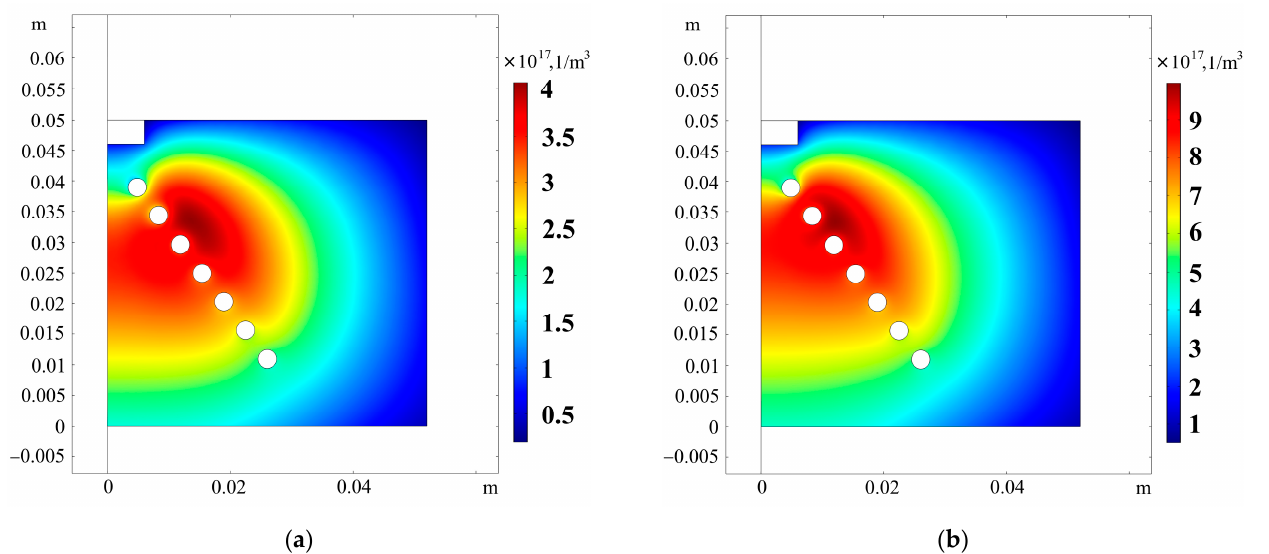
Figure 9. Two-dimensional distribution of charged particle density over the DC volume in the case of using an internal antenna with hemispherical arrangement of turns: ( a ) xenon flow rate of 0.5 mg/s, RF power of 71 W, extracted ion current of 140 mA; ( b ) xenon flow rate of 1 mg/s, RF power of 121 W, extracted ion current of 300 mA.